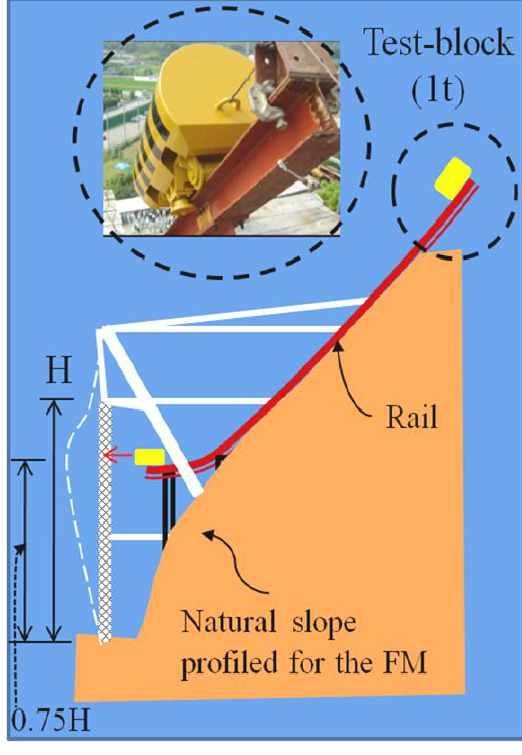
Figure 3. The FST scheme of the R-LPR structure. 3 Fig. 3. The FST scheme of the R-LPR structure. corresponding tension in the cables being installed with the brake devices (dissipators) should also be taken into